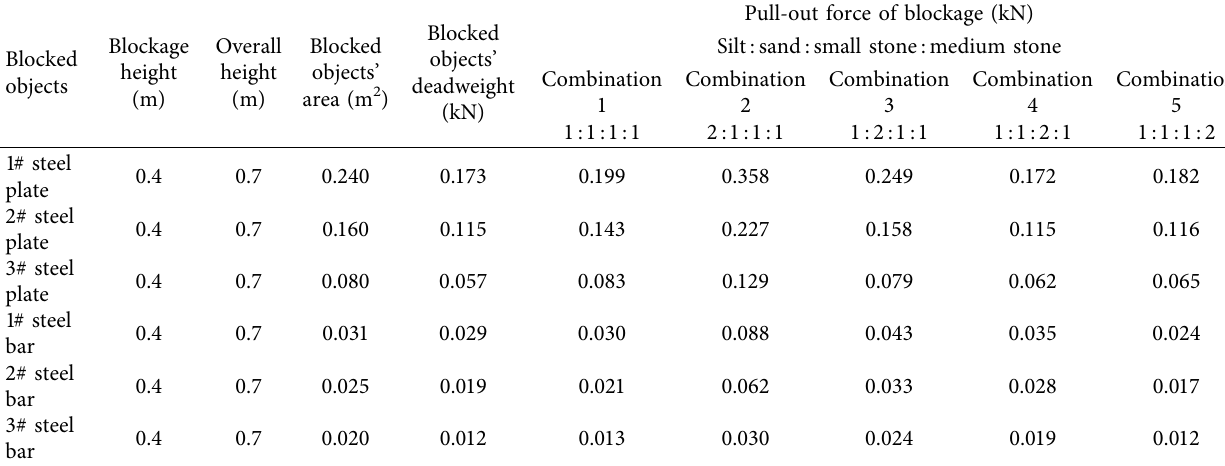
Table 6: Test results of pull-out resistance of the lower gate of the underwater mixed blockage.